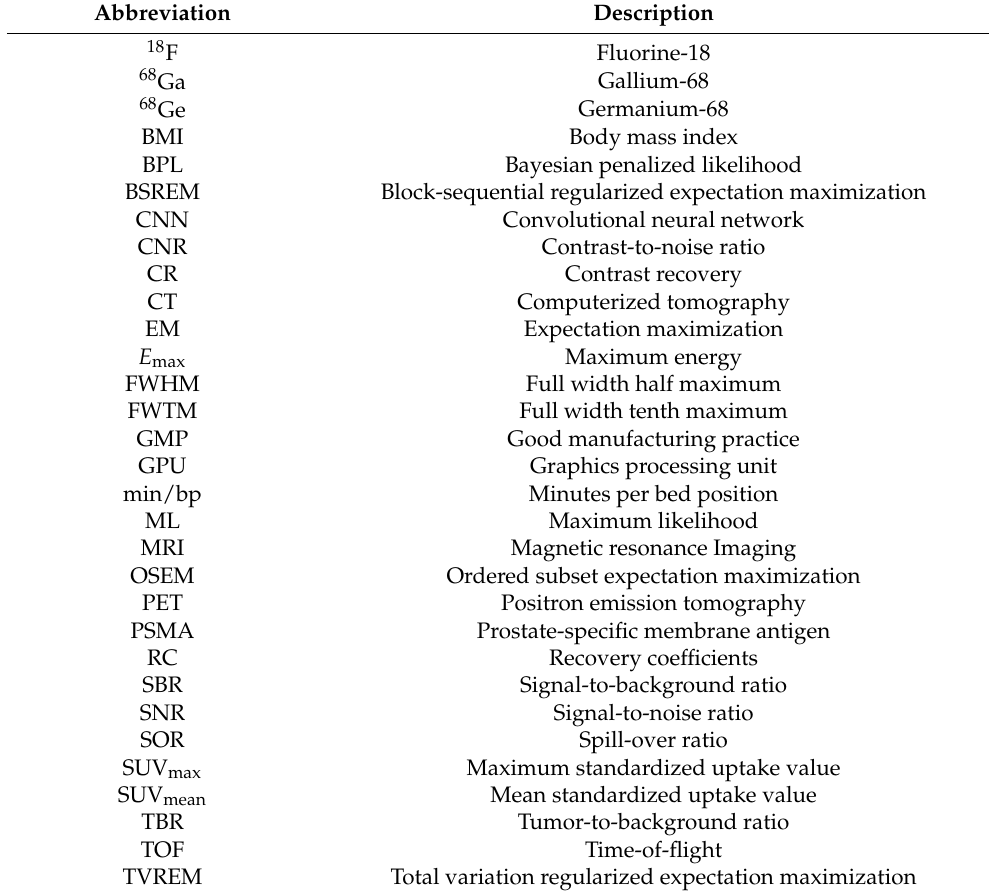
Table 1. Summary of abbreviations in this